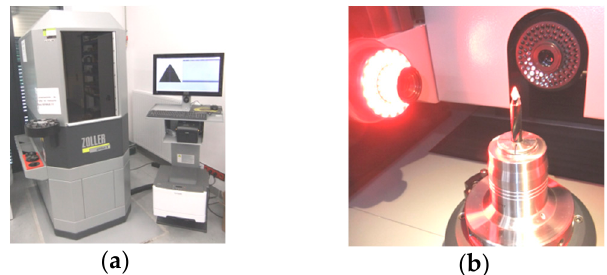
Figure 4. Measuring the cutting tool: ( a ) The Zoller Genius 3 coordinate measuring machine; ( b ) the mounting arrangements and optical system in the Zoller ® Genius 3.